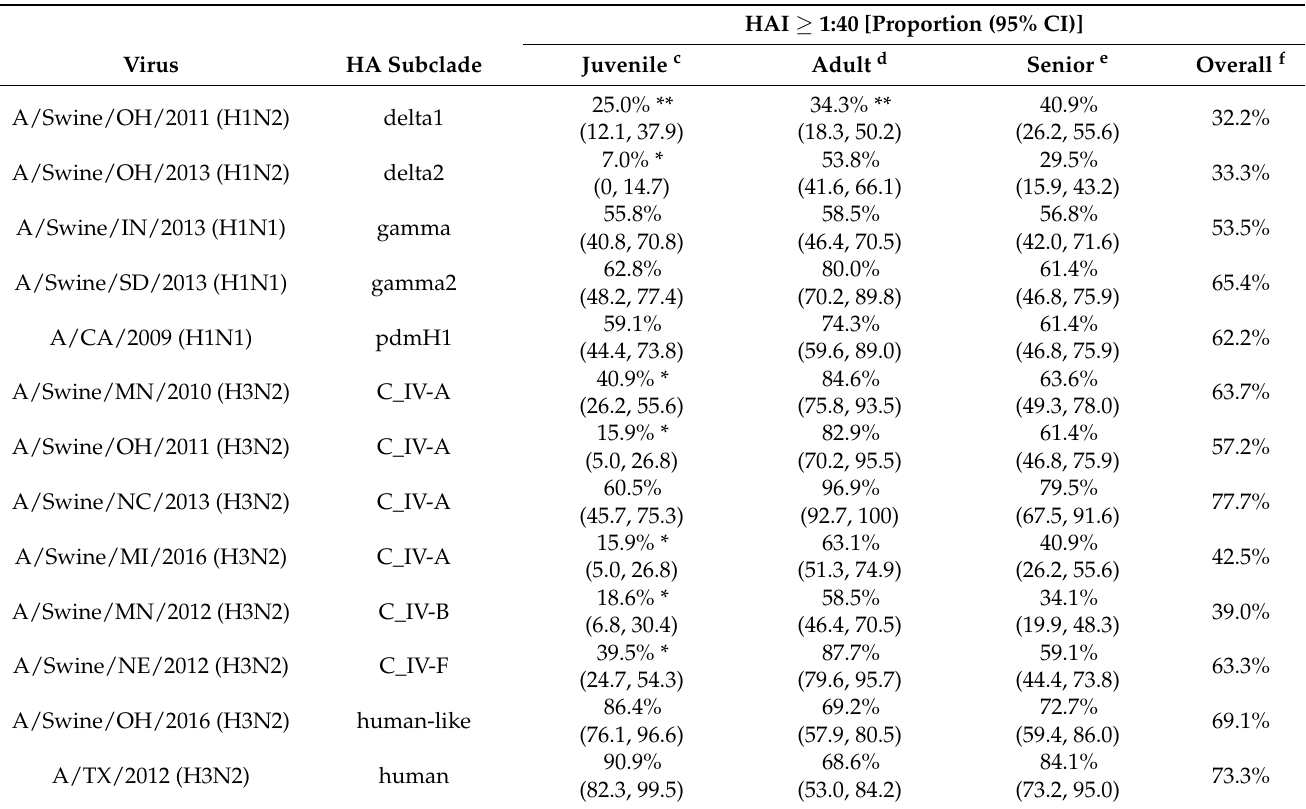
Table 2. Seroprotection rates a against study influenza A viruses by age group b and overall.